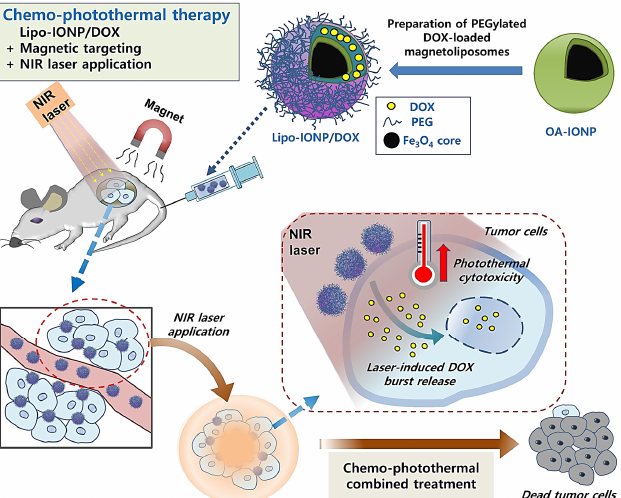
Figure 1. Scheme of the doxorubicin-loaded liposomal iron oxide nanoparticles for magnet-guided and light-triggered combined chemo-photothermal cancer therapy.